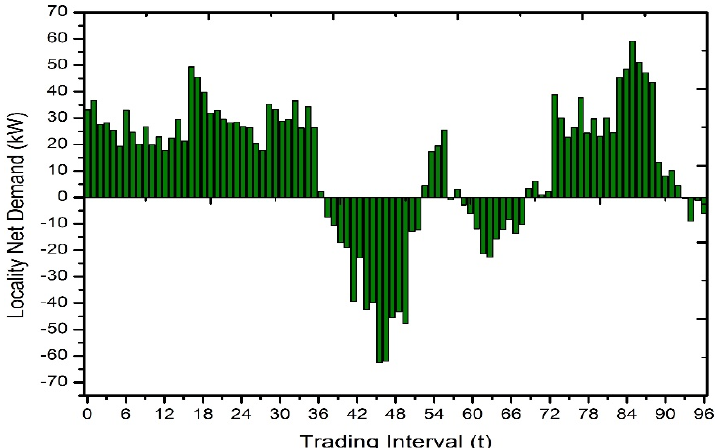
Figure 7. Participant’s daily demand and generation pattern.